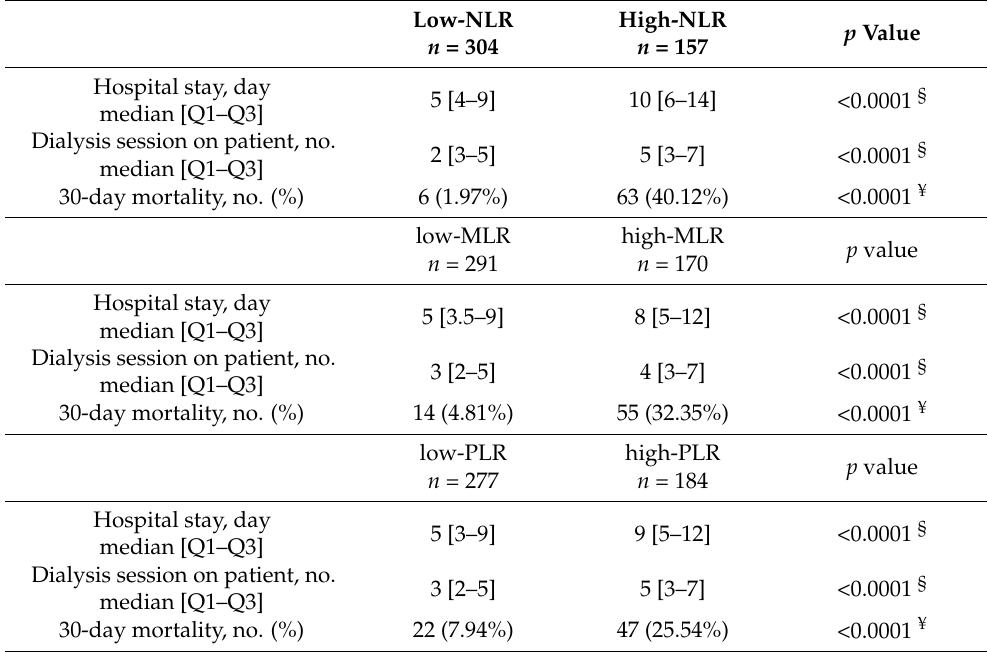
Table 5. Outcomes of the two sub-groups evaluated separately according to the optimal cut-off value of NLR, MLR, and